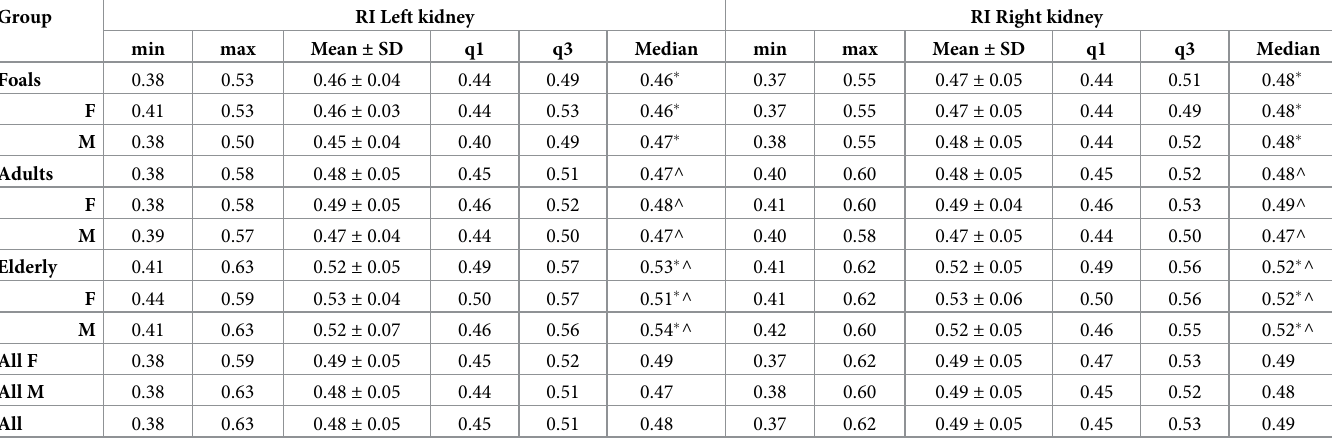
Table 2. Mean values of resistive index of the intrarenal arteries in the studied horses. Group RI Left kidney RI Right kidney